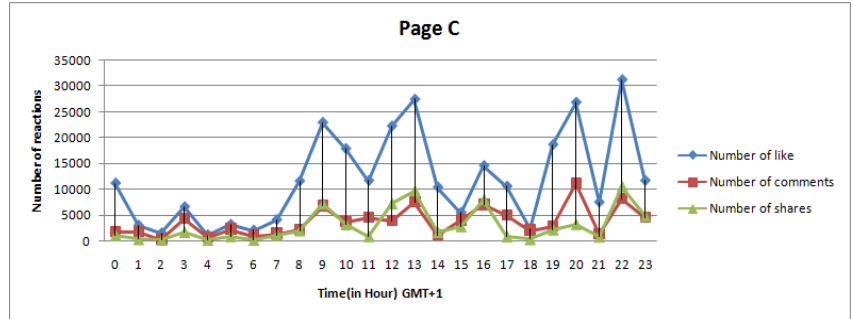
Fig. 5. Number of interactions per publishing hour for page C with 57 posts